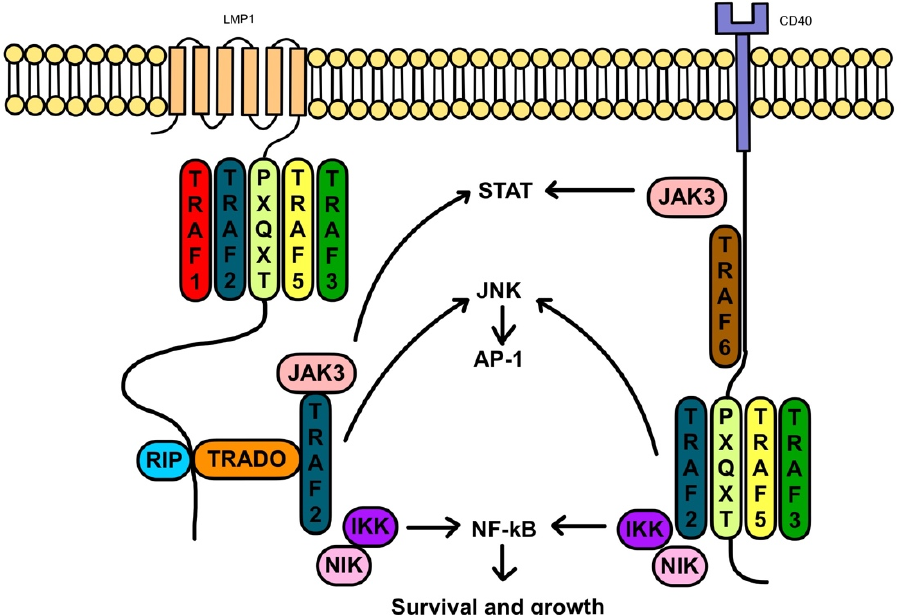
Figure 2. LMP-1 and signaling interactions with CD40. Adapted from Thorley-Lawson, D. Epstein-Barr